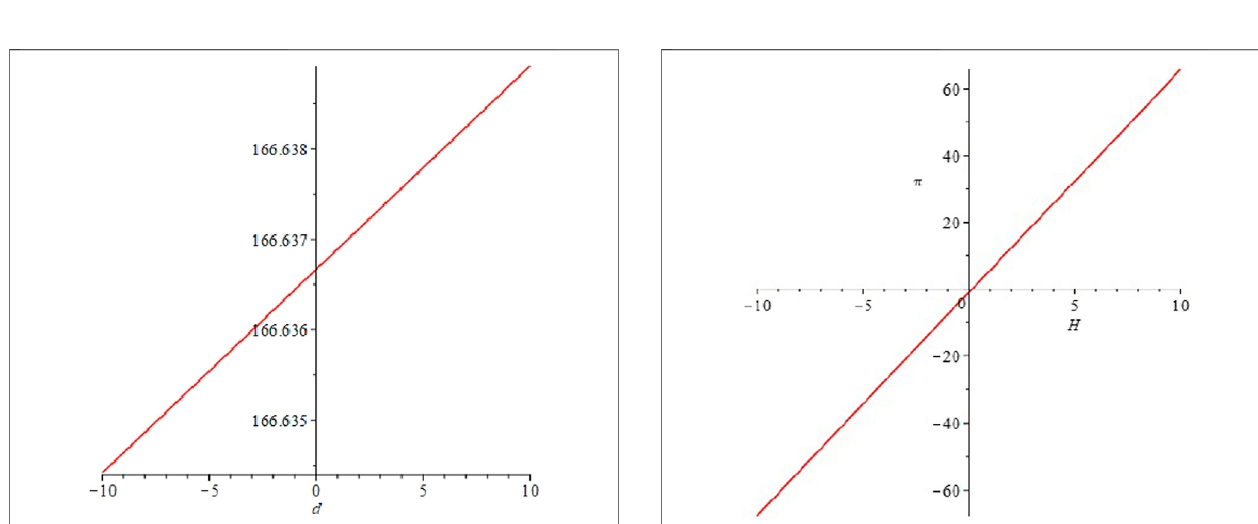
3 and total carbon quota H